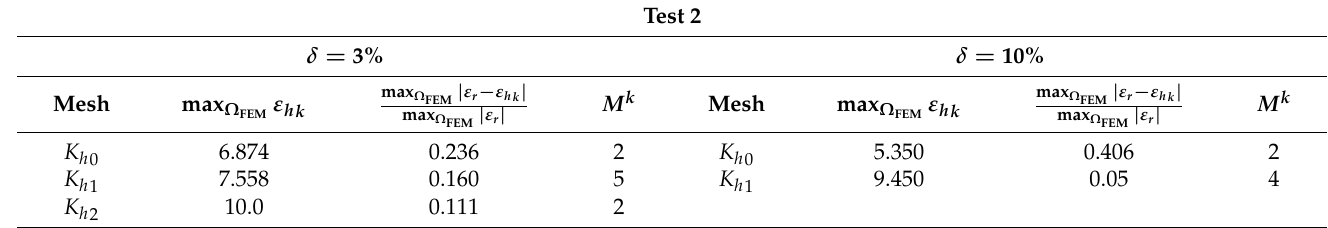
ε hk on a coarse and on Table 3. Test 2. Computational results of the reconstructions max Ω FEM adaptively refined meshes together with relative errors computed in the maximal contrast of ε r ,max Ω ε hk . Here, max Ω ε hk denotes the maximum of the computed function ε h on max Ω FEM FEM FEM k -times refined mesh K hk in the domain Ω FEM , and M k denotes the final number of iterations in the conjugate gradient Algorithm 3 on k -times refined mesh K hk for reconstructed function ε hk , k = 0,1,2. Test 2 δ = 10%